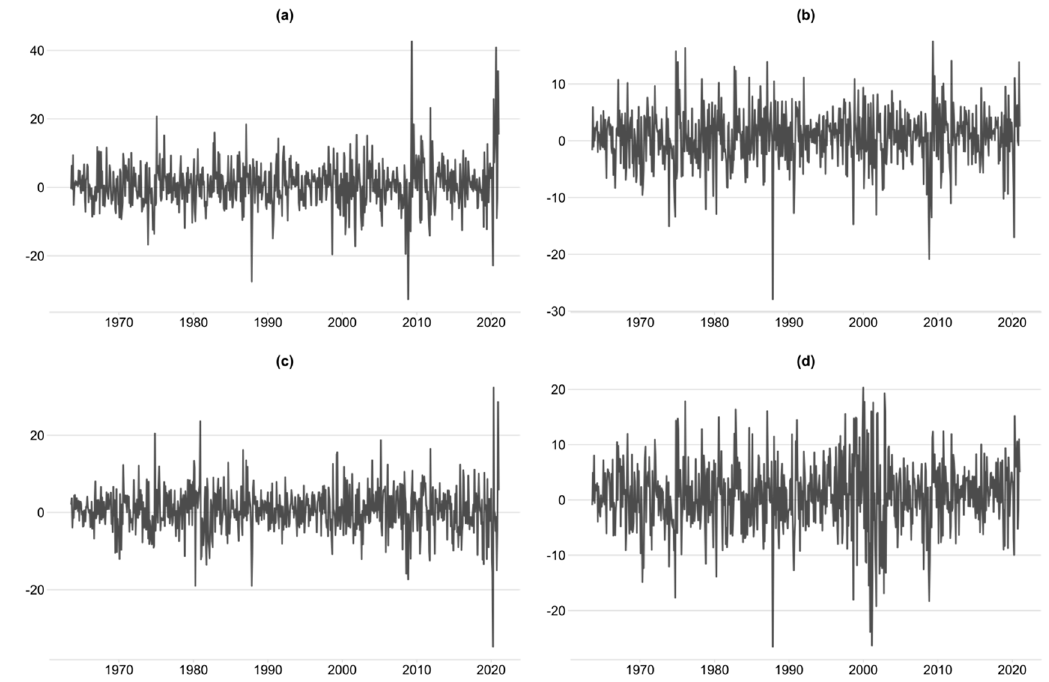
Figure 1. Monthly industry portfolio excess returns: ( a ) Consumer durables; ( b ) Manufacturing; ( c ) Energy; ( d ) High tech. Note: The figure presents the plots for monthly excess portfolio returns over the sample period of July 1963–December 2020.